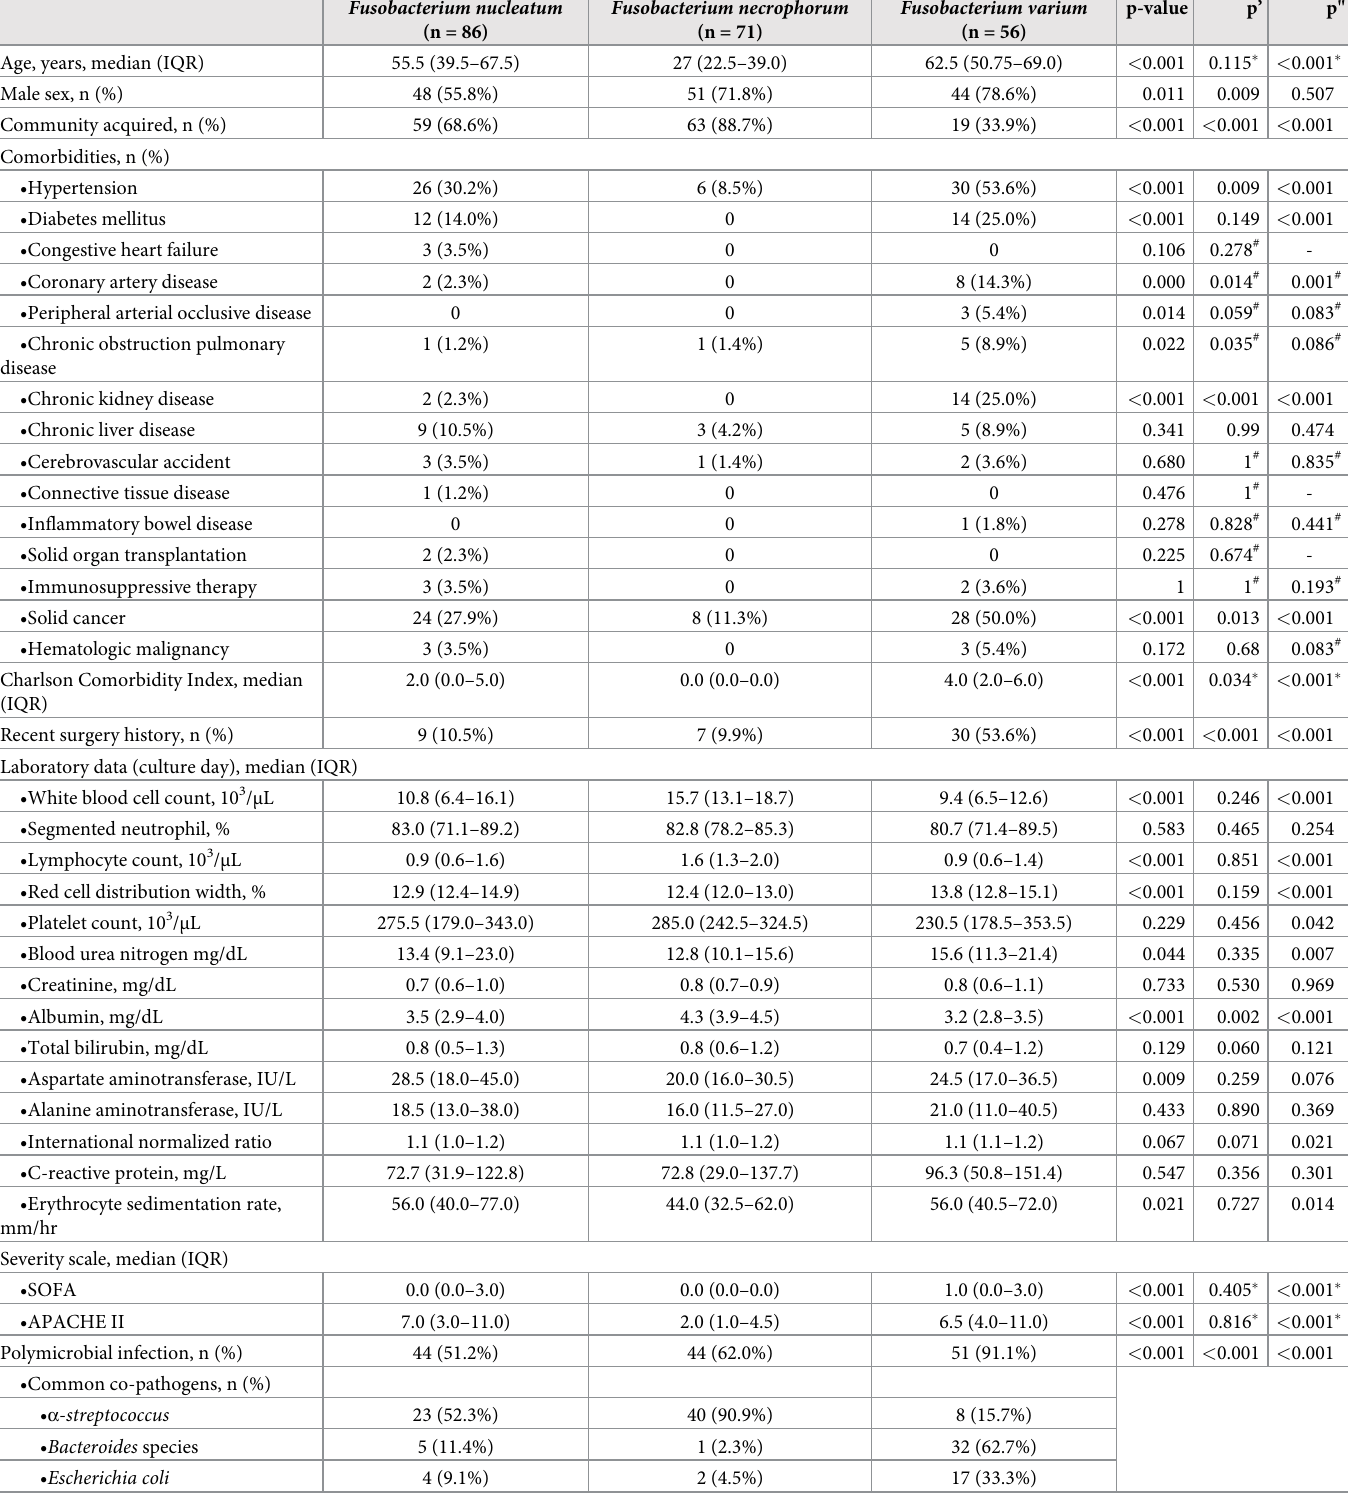
Table 1. Comparison of clinical characteristics of each